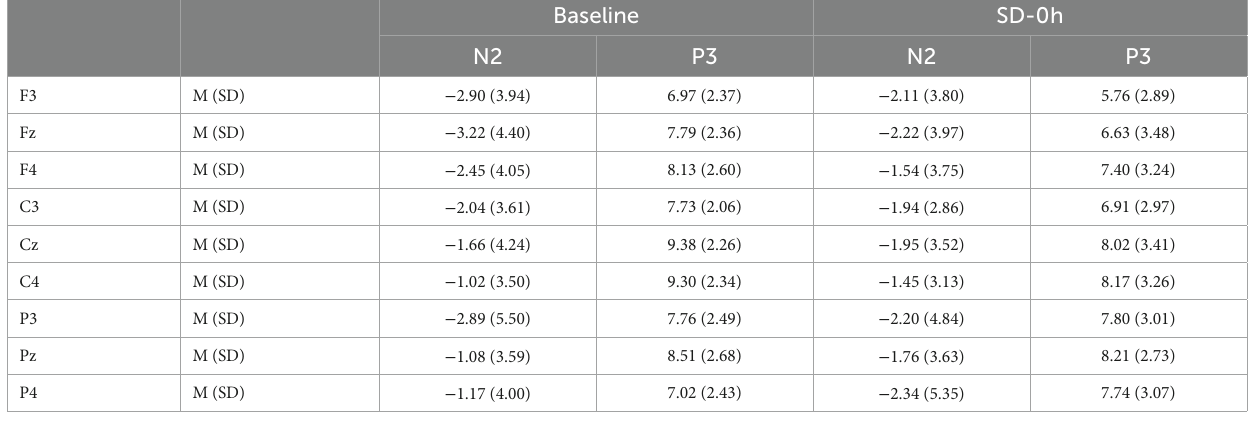
TABLE 4 Grand-average peak amplitude of the N2 and P3 components for correct responses across multiple electrode sites at baseline and after 0 h of sleep deprivation (SD0) in the nocturnal sleep (NS) group.